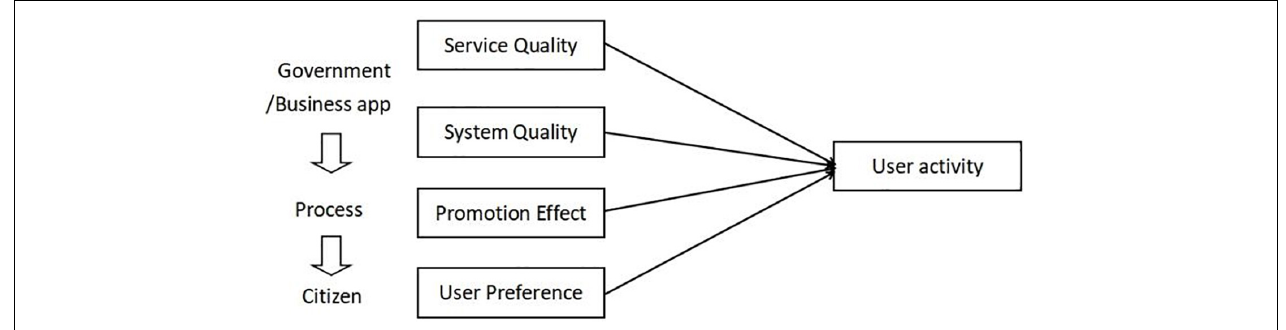
FIGURE 2 | The basic influencing factors model of user activity.